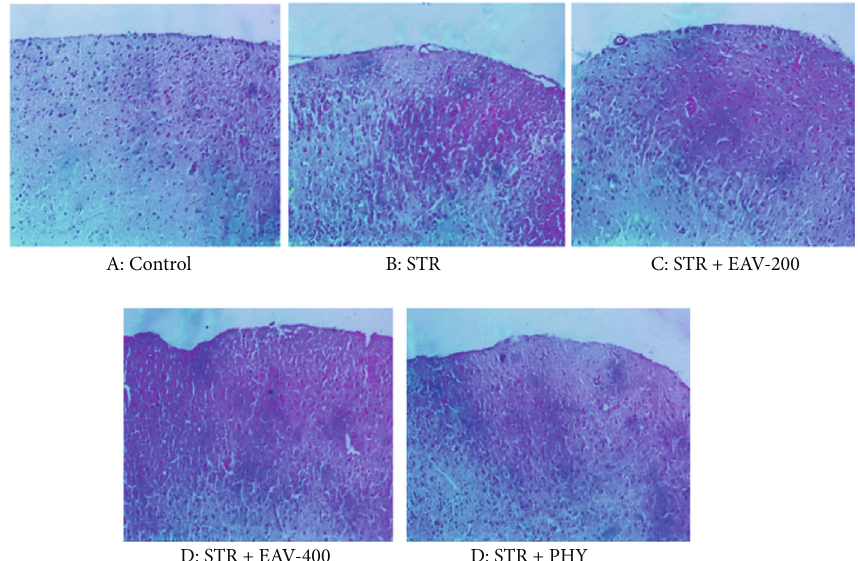
Figure 6: Shows the di ff erences anatomically in STR-induced duration of convulsion, STR +EAV-200, STR +EAV-400, control, and